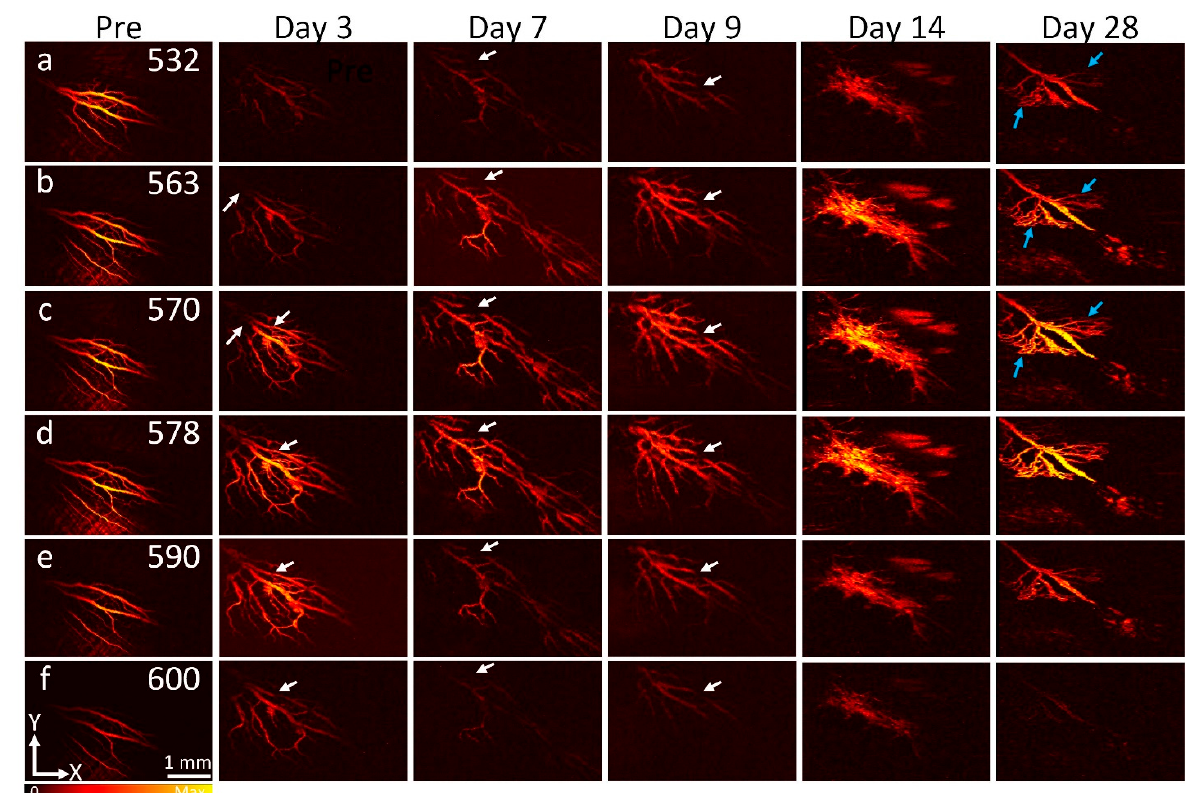
Figure 4. Longitudinal spectroscopic PAM visualization of RVO before and after laser irradiation. ( a – f ) PAM images obtained at different wavelengths (532–600 nm) and different time points before and after laser treatment for up to 28 days. White arrows demonstrate the injury vessels. At the treated location, the PAM image contrast was decreased and blurred in comparison to the untreated areas. The treated retinal vessels were detected at all wavelengths. However, the strongest PA contrast occurred at the wavelengths from 563 to 578